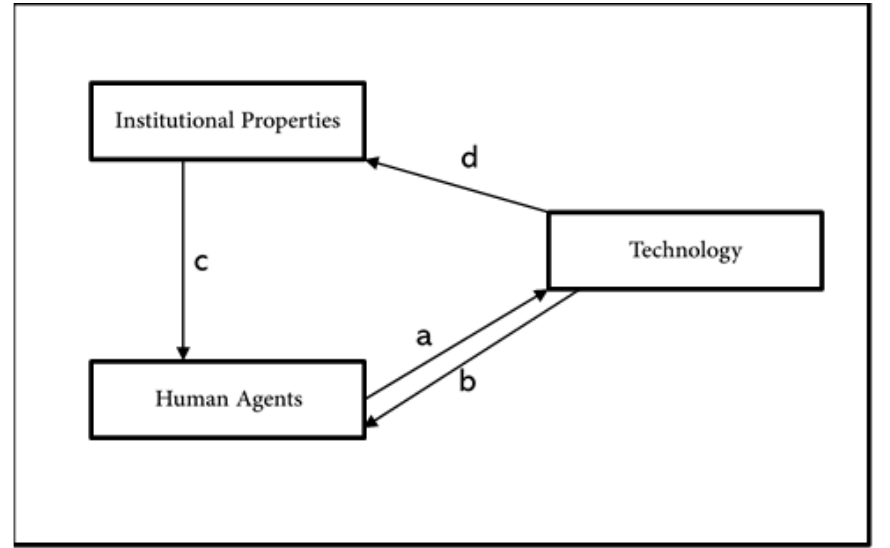
Figure 1: Structurational Model of Technology (Orlikowski, 1992, p. 410)